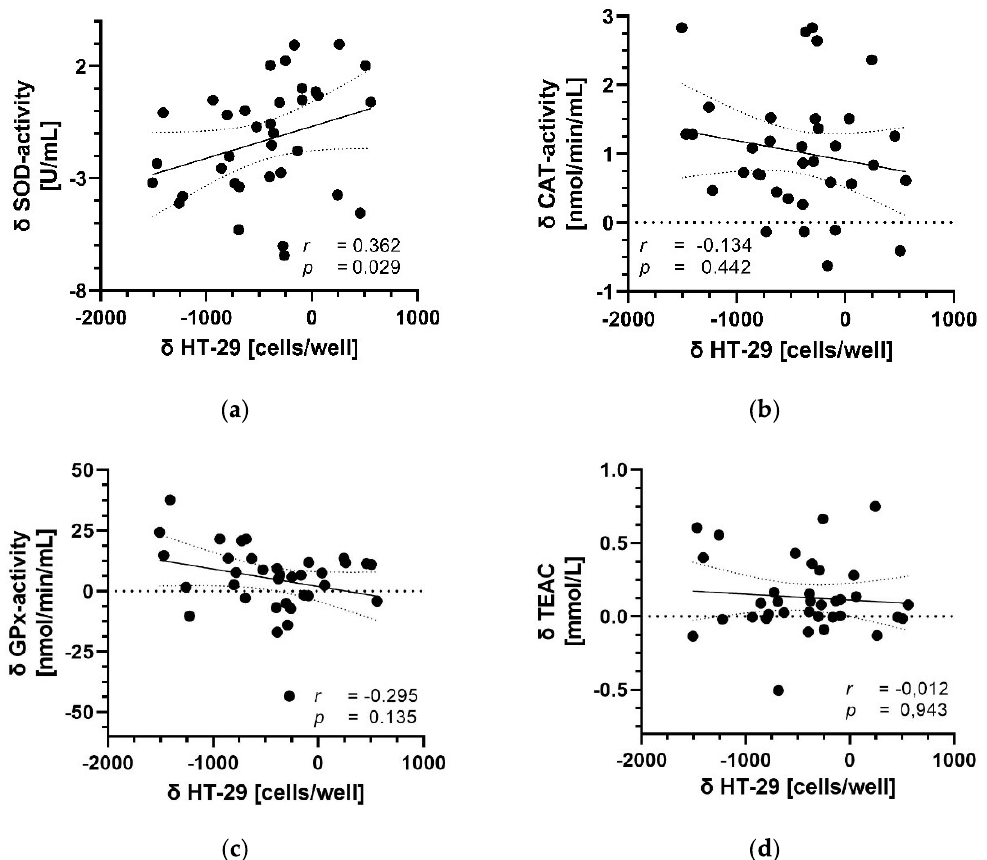
Figure 5. Scatter plots of antioxidant parameters and HT-29 migration. Correlation between HT-29 cell migration in vitro and SOD activity ( a ), CAT activity ( b ), GPx activity ( c ), and TEAC ( d ) in plasma. Correlation between the parameters were evaluated using Spearman correlation (r) with differences ( δ ) between values from day 28 and day 0 after anthocyanin-rich juice intake ( n =